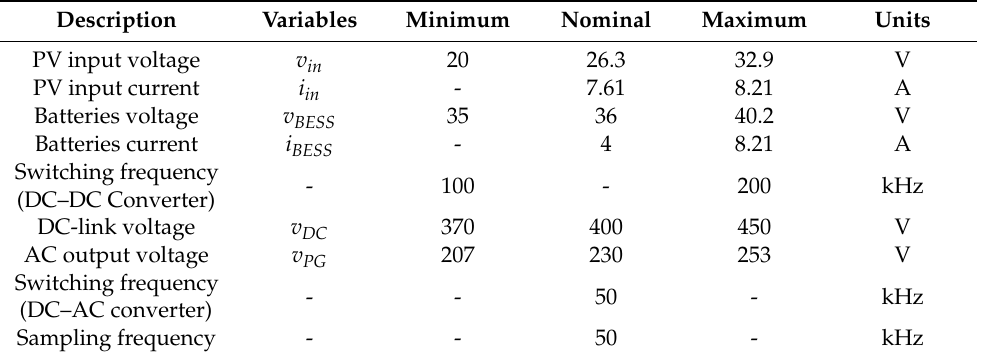
Table 4. Specification of multifunctional isolated microinverter operating conditions.